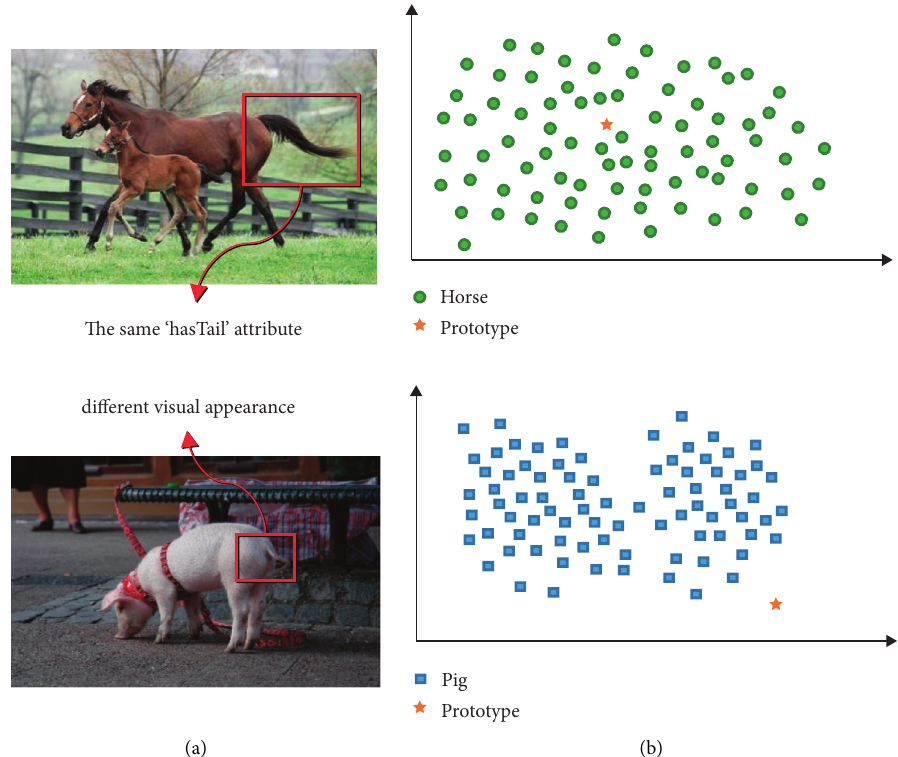
Figure 3: An illustration of the domain shift problem in zero-shot learning image classification. As we can see from the picture, both horses and pigs have tail attributes, but the visual characteristics of their tails are far apart. It is difficult to correctly identify pigs if the model is trained by horses. (a) Visual space. (b) Attribute